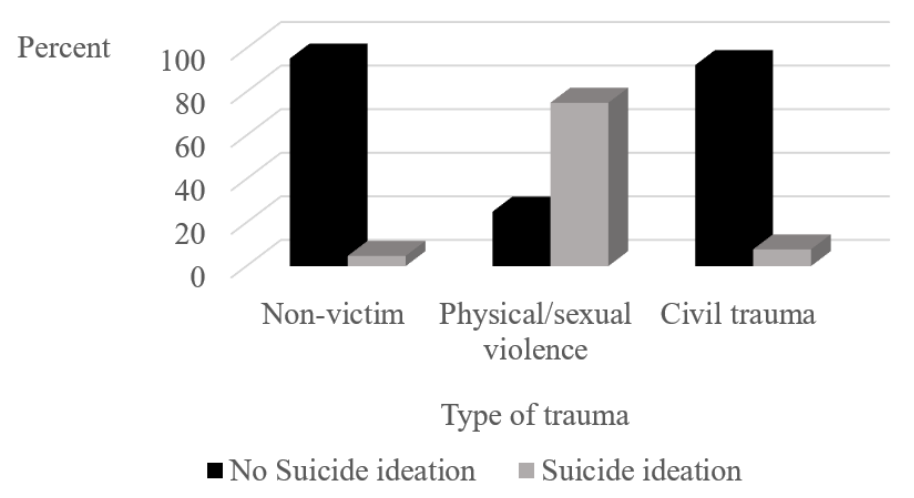
Figure 4. Percentage of asylum seekers with and without suicide ideation as a function type of trauma in Israel ( n = 193).